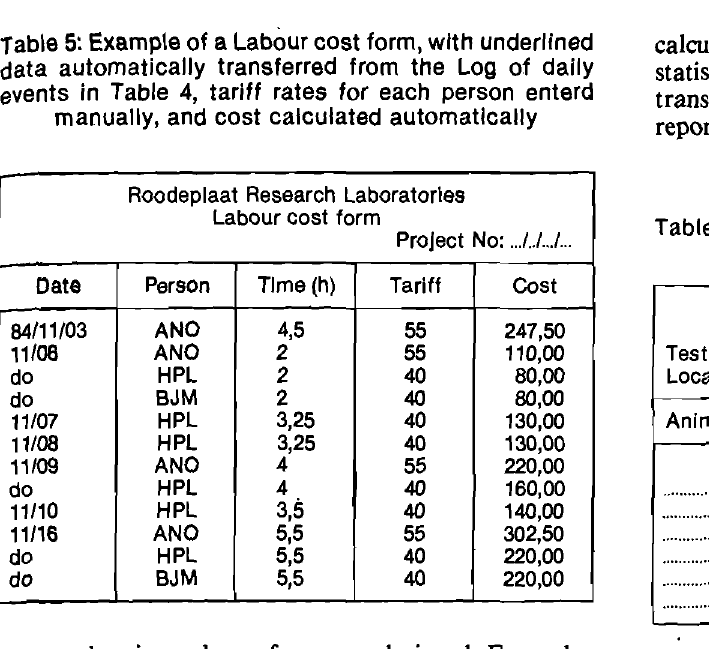
Table 7: Part of a data recording form for trial animal